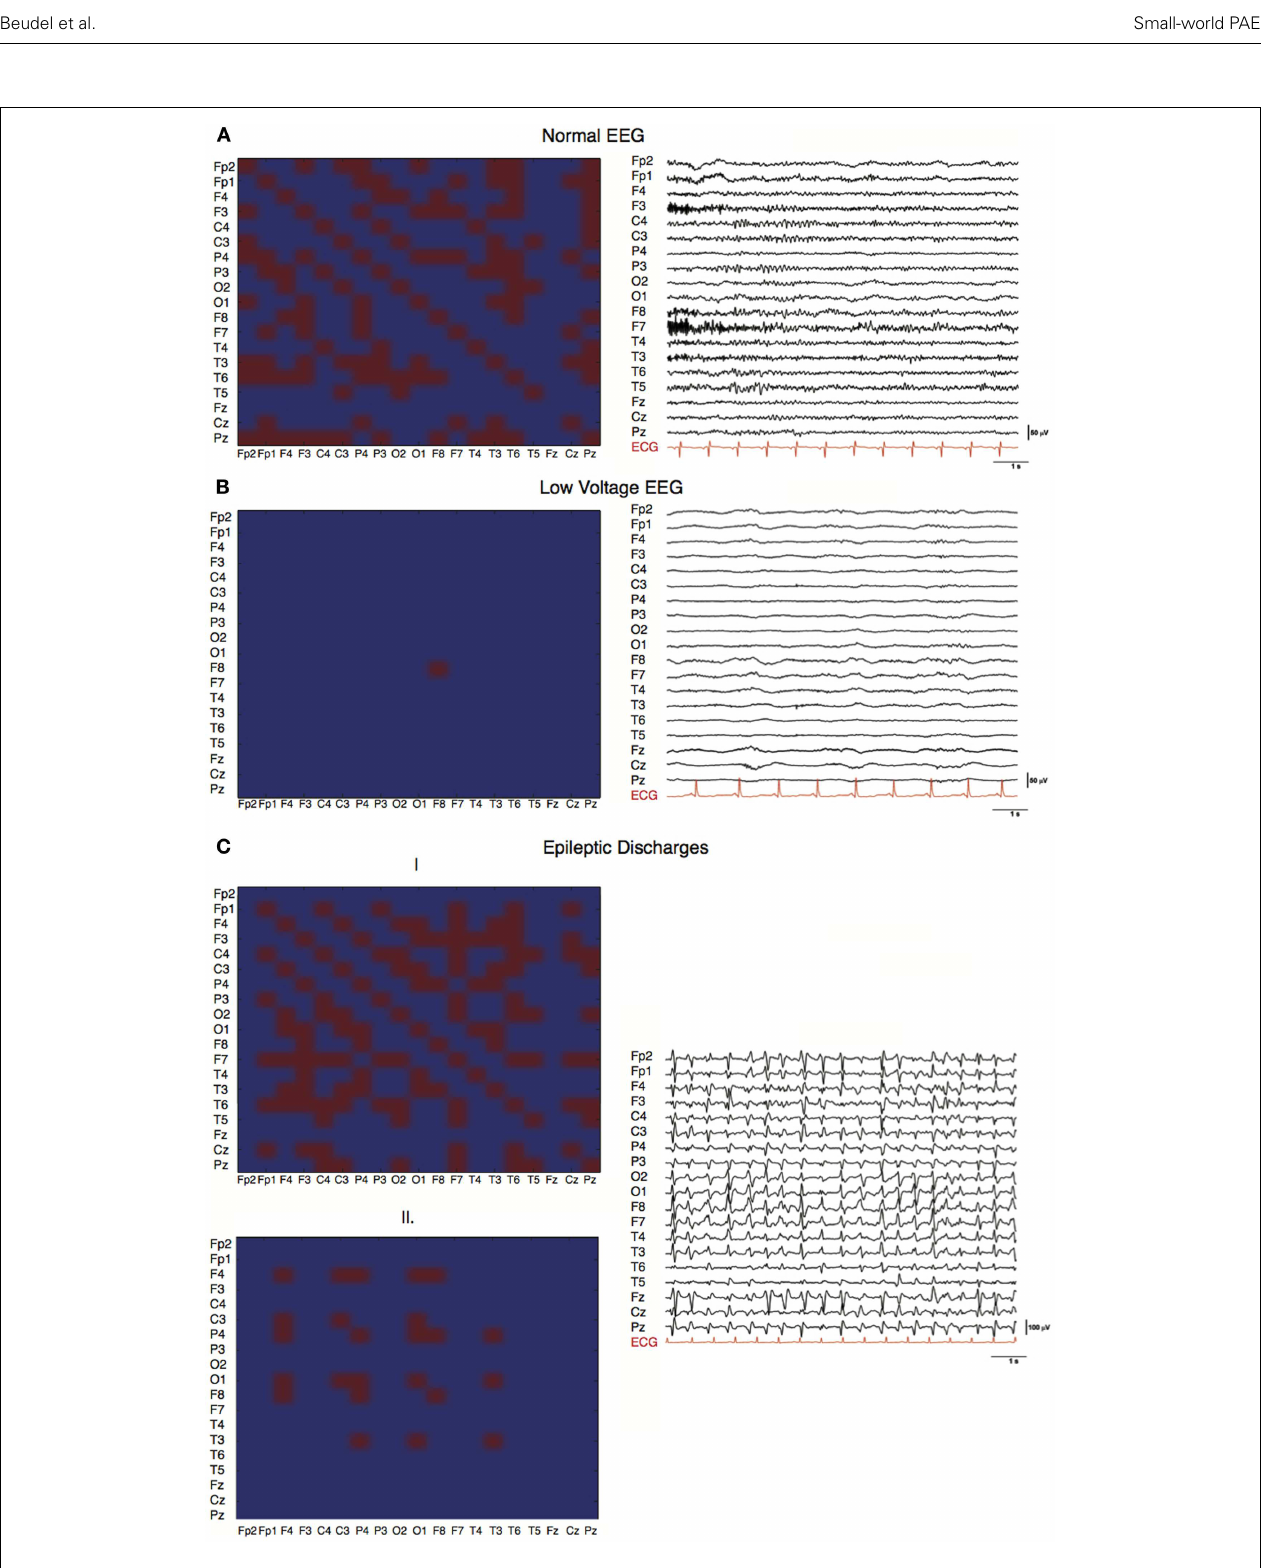
FIGURE 1 | Characteristic EEGs and their network configurations . Horizontal and vertical axes show the different EEG electrodes. Red squares represent connections, blue squares represent absent connections. (A) Adjacency matrix of a PAE patient with a good EEG showing involvement of 160 of the possible 361 (19 × 19) connections and involvement of 18 of the 19 electrodes in the network ( C = 0.81, L = 1.77, SWI = 0.45). (B) Adjacency